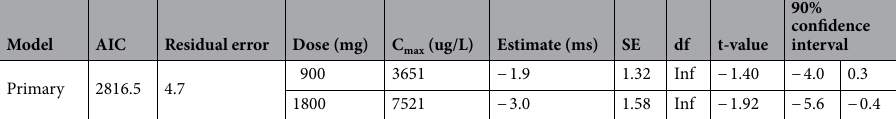
Table 3. Predicted effects of nolasiban on ΔQTcF at geometric mean maximum concentrations for each dose group. SE standard error, df degrees of